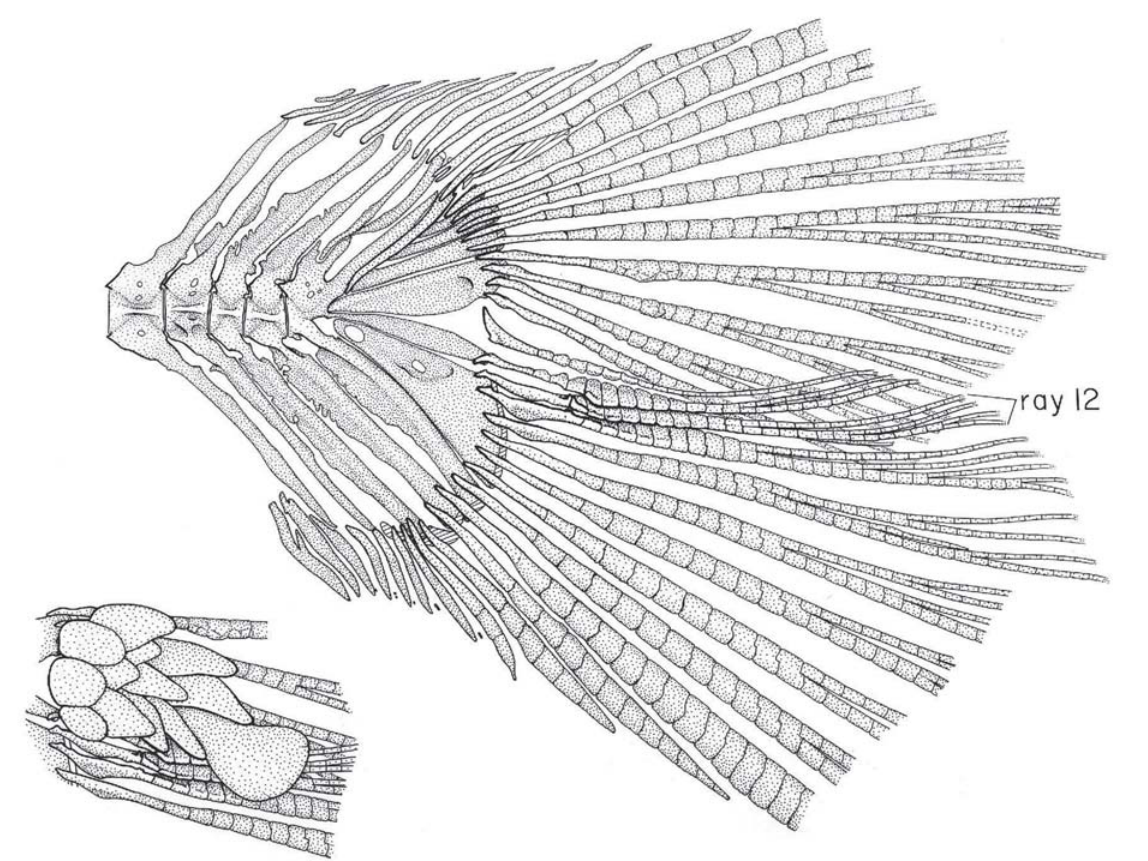
Fig. 32. Mimagoniates inequalis , adult male, MCP 9892, 37.0 mm SL; osteology of caudal skeleton and caudal-fin squamation (lower left inset) lateral view, left side. Cartilage represented by crosshatching.